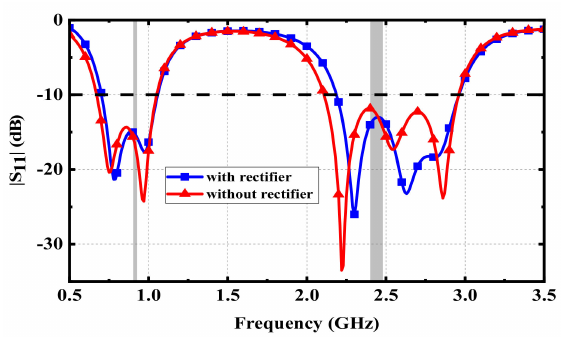
Figure 15. Effect of adding the rectifier layer on the proposed antenna.